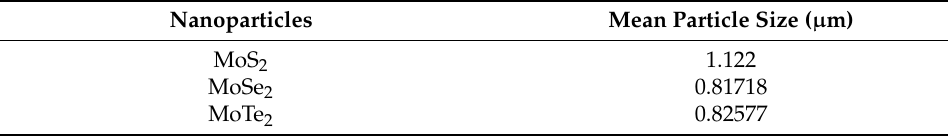
Figure 2. SEM images and grain size distribution for the molybdenum chalcogenides. Table 3. Grain size distribution for the MoX 2 NPs calculated using SEM analysis.